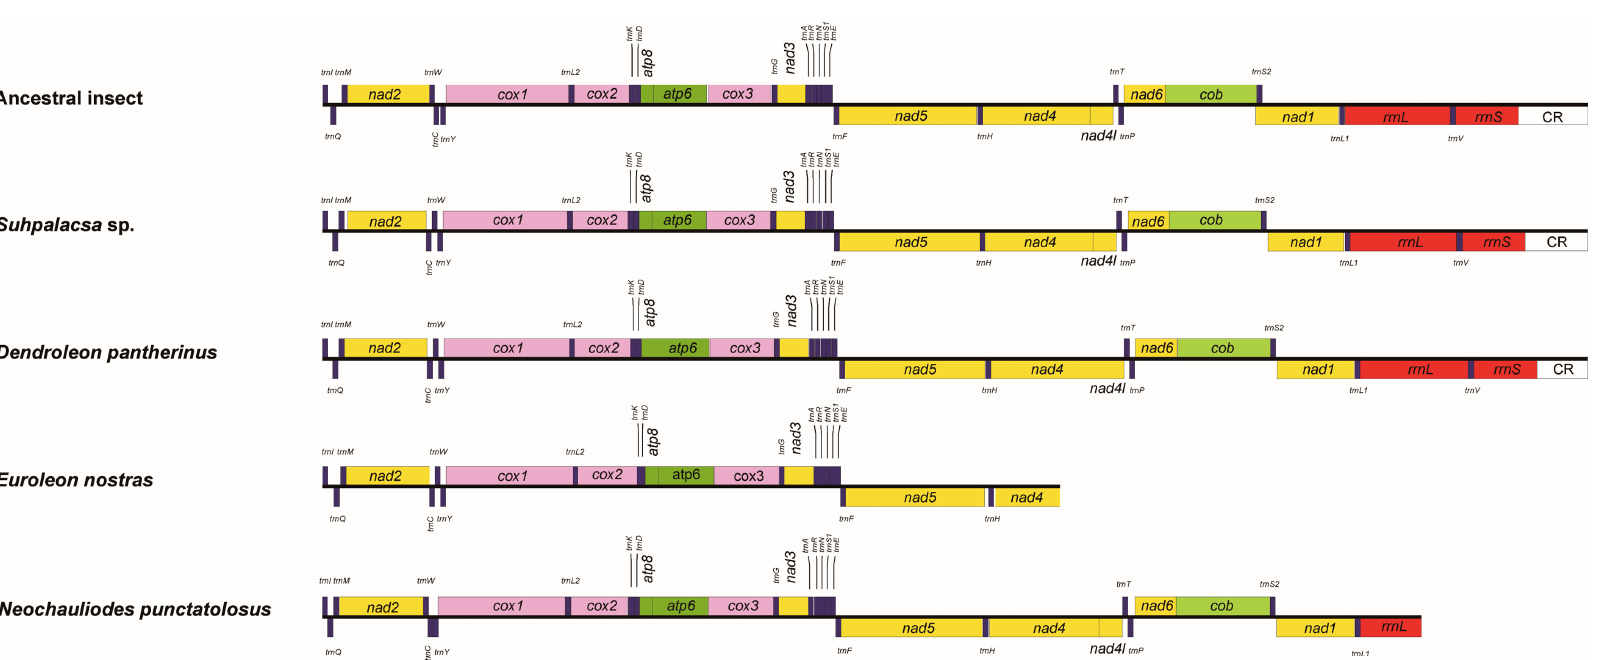
Figure 1. Comparison of structures of mitochondrial genomes among Suhpalacsa sp., Dendroleon pantherinus , Euroleon nostras , Neochauliodes punctatolosus and the putative ancestral insect. Linearized representation illustrates the gene arrangements of the circular genomes. The mitochondrial genomes of Suhpalacsa sp. and D. pantherinus are nearly complete. The E. nostras and N. punctatolosus have the partial mitochondrial genomes. The transcriptional direction of mitochondrial genes labeled above the line is from left to right and those labeled below the line indicate the opposite